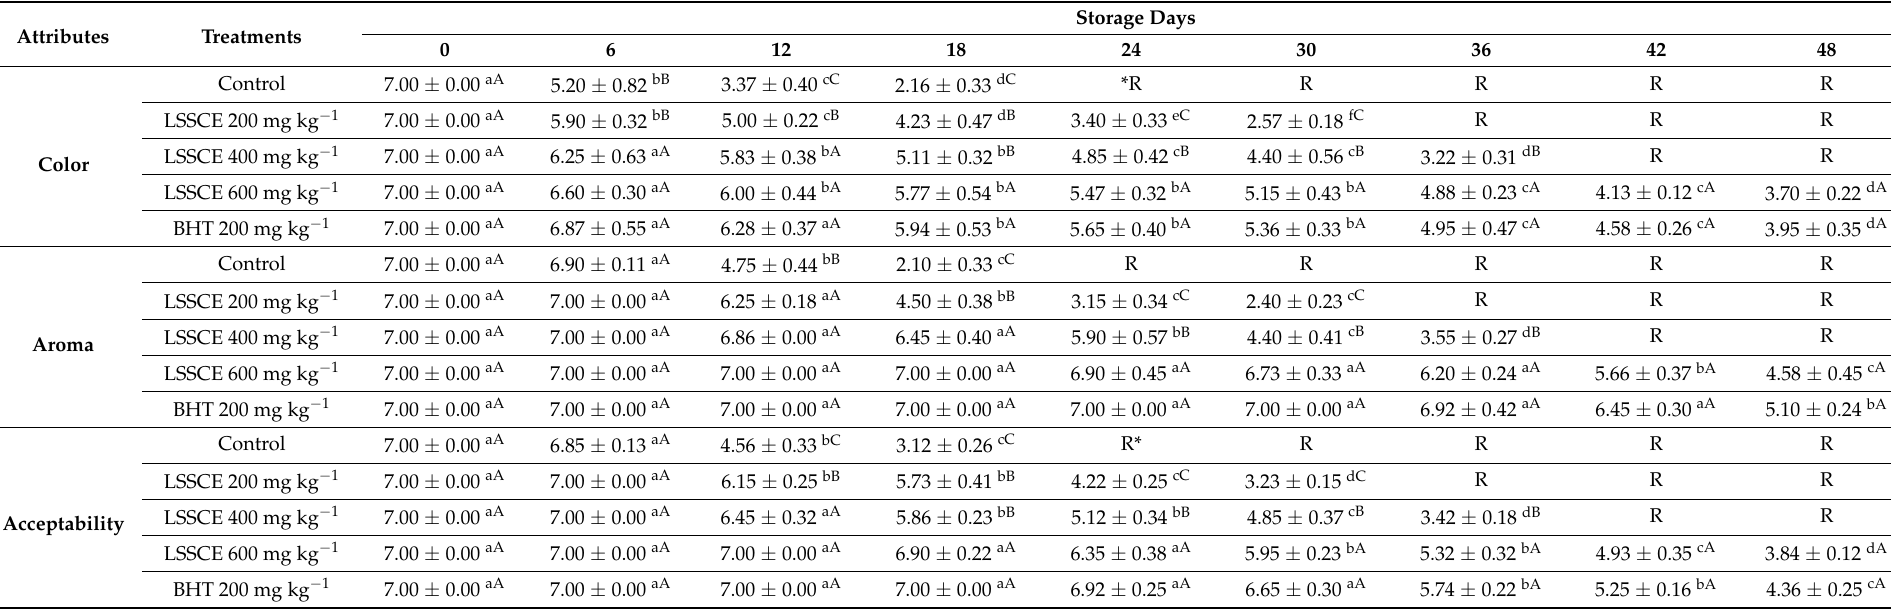
Table 4. Organoleptic responses for color, aroma, and acceptability of refined olive oil (ROO) samples stored at 60 ◦